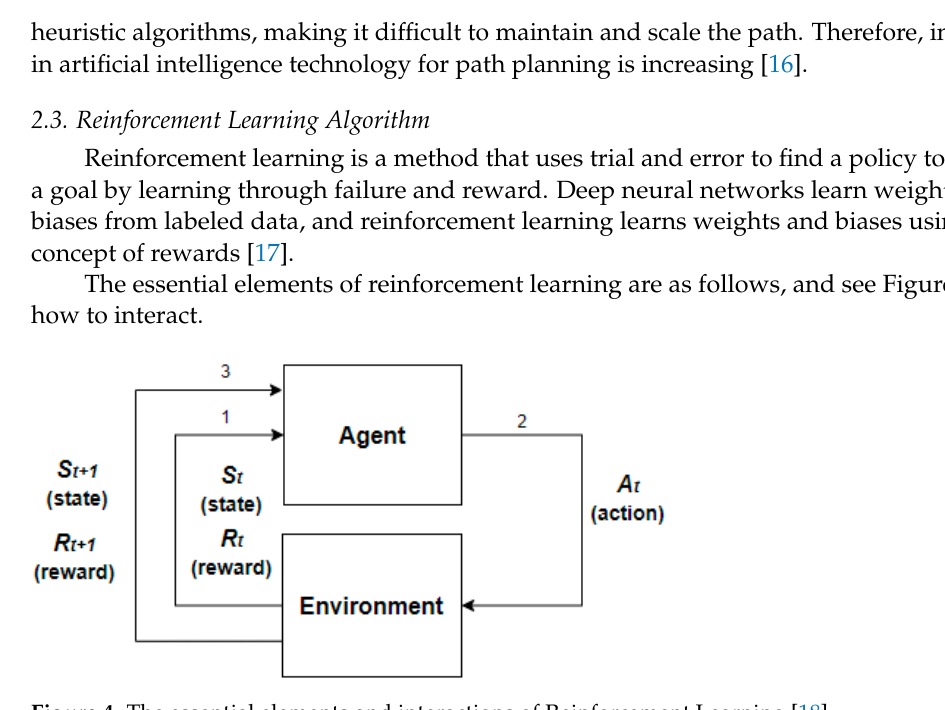
Figure 4. The essential elements and interactions of Reinforcement Learning [18].